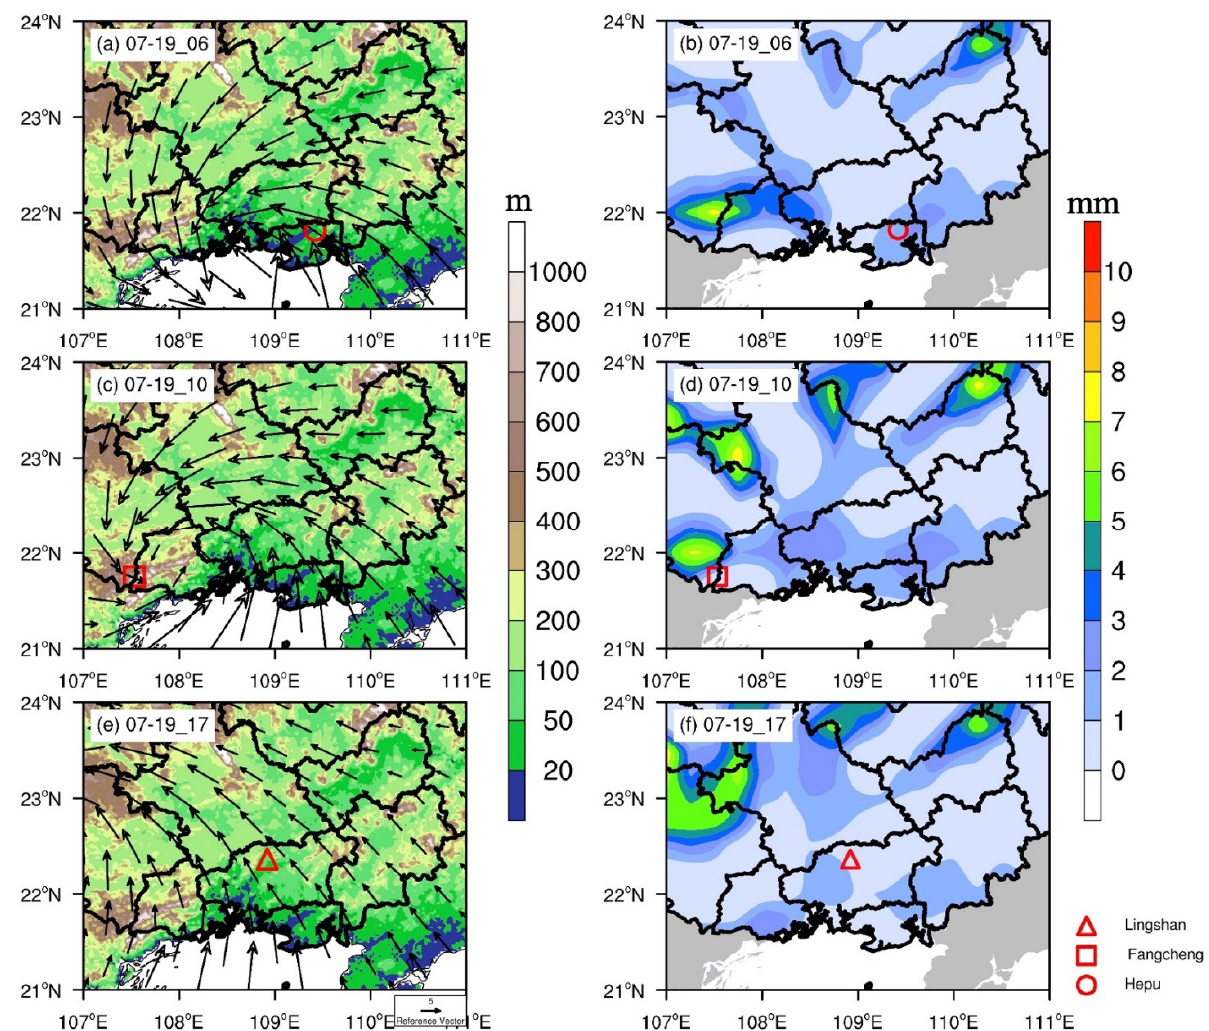
Figure 8. Left panels ( a , c , e ): the geographic distributions of terrain heights (shadings, m) overlaid with 10 m wind (vectors, m s − 1 ) at the peak for Hepu, Fangcheng, and Lingshan rainstorms with the red markers denoting the rainstorm centers. Right panels ( b , d , f ): the corresponding diagnosed hourly orographic precipitation (mm) using ERA5.